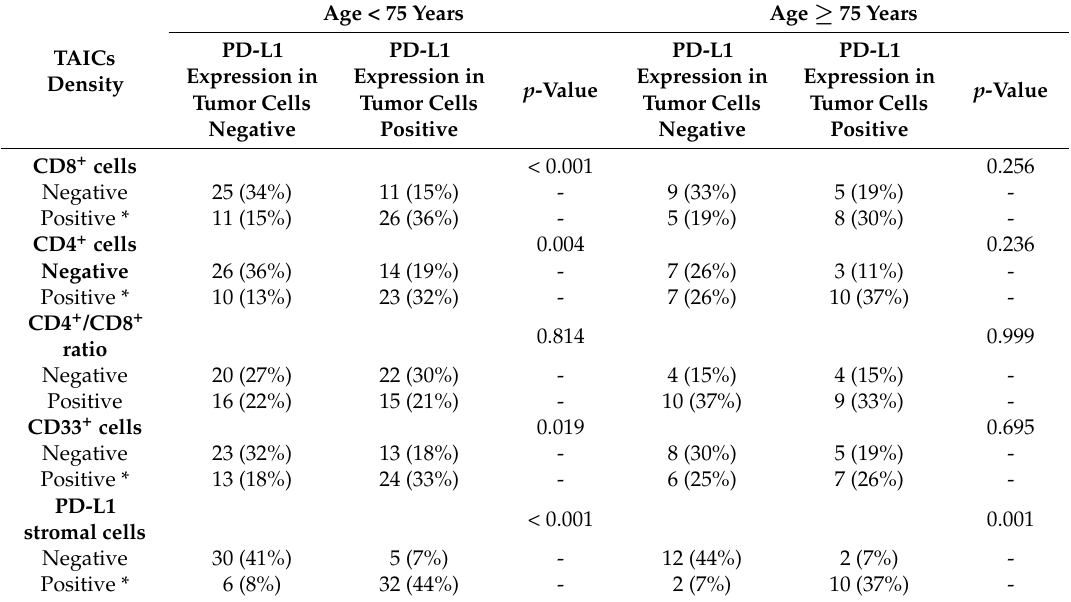
Table 2. Distribution of the types of microenvironment in LADC age-stratified specimens based on the PD-L1 expression in tumor cells or in immune cells, and on the density of TAICs. The Fisher’s exact test was